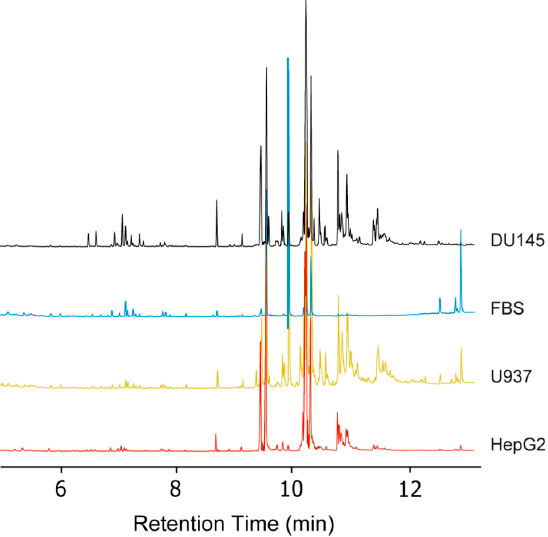
Figure 5. Automated derivatization improves %RSD trend ( A ). The ratio of the %RSD from the automatically derivatized fatty acid standards plotted over the %RSD of the manually derivatized fatty acid standards. The dotted red line represents a slope of 1 across the plot. Fatty acids that lie beneath that line demonstrate improved automation %RSD values. The blue line is a linear trendline derived from the data points. ( B ) The fatty acid derivatization ratios for all biological matrices (human prostate cancer cell line DU145, FBS, human liver cancer cell line HepG2, and human myeloid leukemia cell line) were tested.